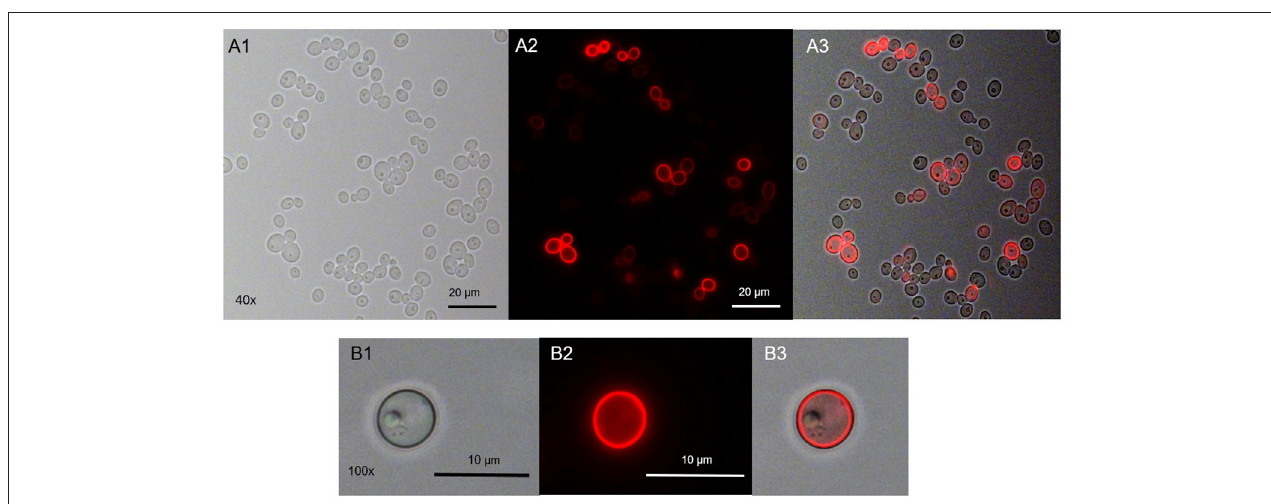
FIGURE 3 | Spatial distribution of TMPyP in C. albicans before irradiation. C. albicans was incubated with 1 µ M TMPyP for 15min and kept in the dark. Fluorescence microscopy revealed a ring-shaped fluorescence pattern of TMPyP suggesting that TMPyP accumulates in the cells’ periphery before irradiation. A1 and B1 show C. albicans cells incubated with TMPyP that were imaged by brightfield microscopy, A2 and B2 show the same cells imaged by fluorescence microscopy (filter: RedFP) and A3 and B3 show the overlay of brightfield and fluorescence micrographs.